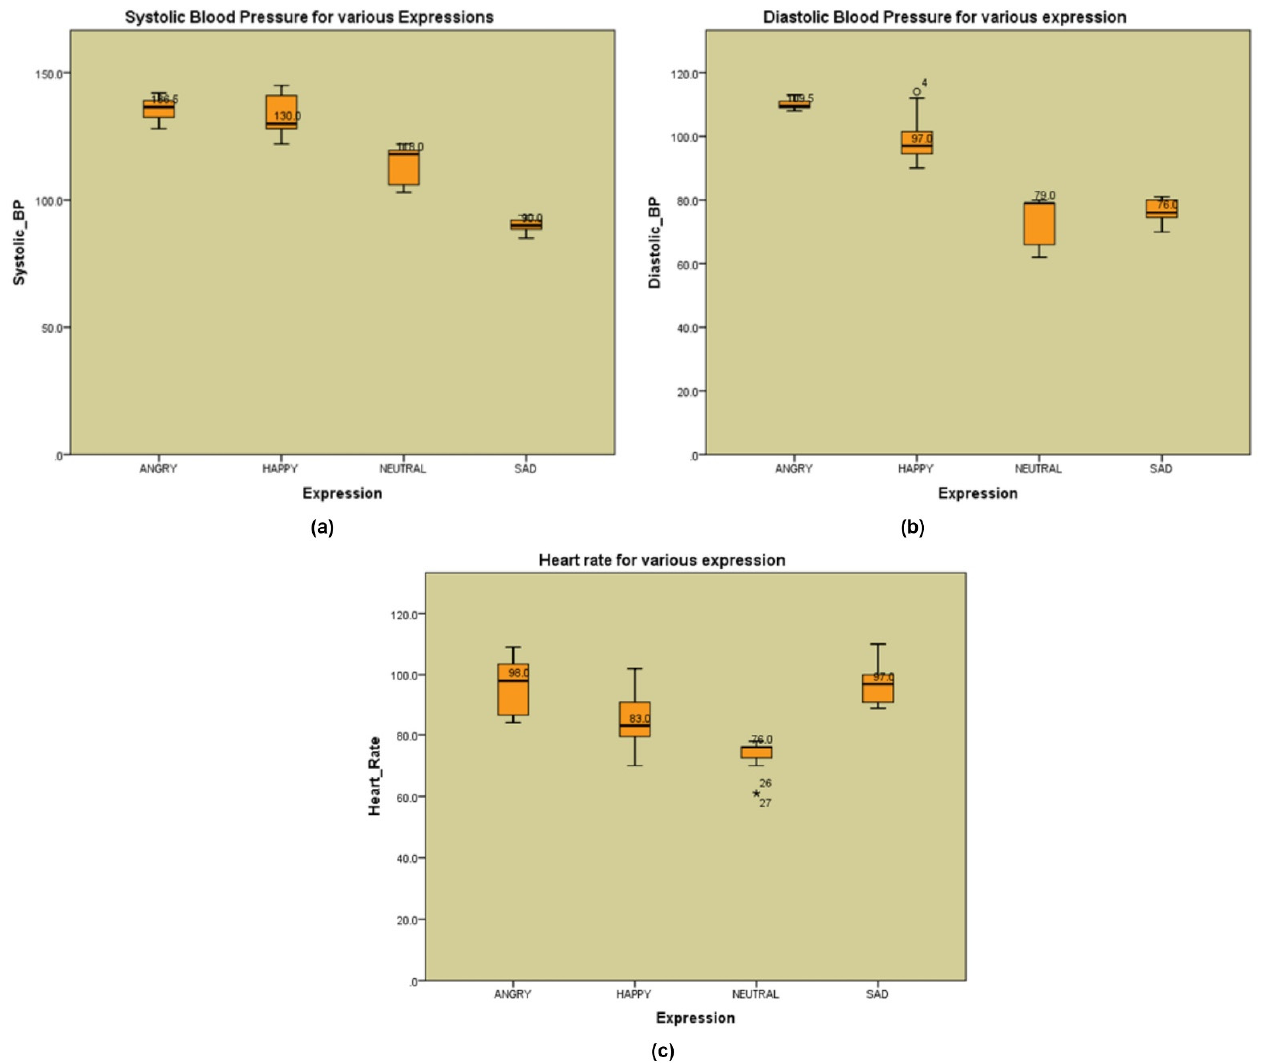
Figure 14. Box plots: ( a ) systolic blood pressure, ( b ) diastolic blood pressure, and ( c ) heart rate. Figure 14c shows the box plot of the heart rate variation of the participants for all four expressions. From the box plot, it is clear that anger raises the blood pressure of participants to the maximum level while the neutral state has shown the minimum. The first quartile and third quartile for each expression are also shown, which shows 25% and 75% of the values are lying under these quartiles. The medians for all the recorded values are also labeled on the box plot of each expression, which depicts the distribution of the Heart rate values for that particular state. Two outliers for the neutral state, i.e., 26th and 27th value recorded and located at the 26th and 27th value in Table 4. Both the values are the same and comparatively low when compared to other recorded values, i.e., 61, hence depicted as an outlier. In order to validate the variation of physiological recorded values for various mental states, a paired-sample t -test has been applied. A paired-sample t -test is the statistical solution and is mainly used when we want to see if the mean difference between the two sets of observations has been found or not. Therefore, to validate our variation on the experimentally recorded values, this test has been